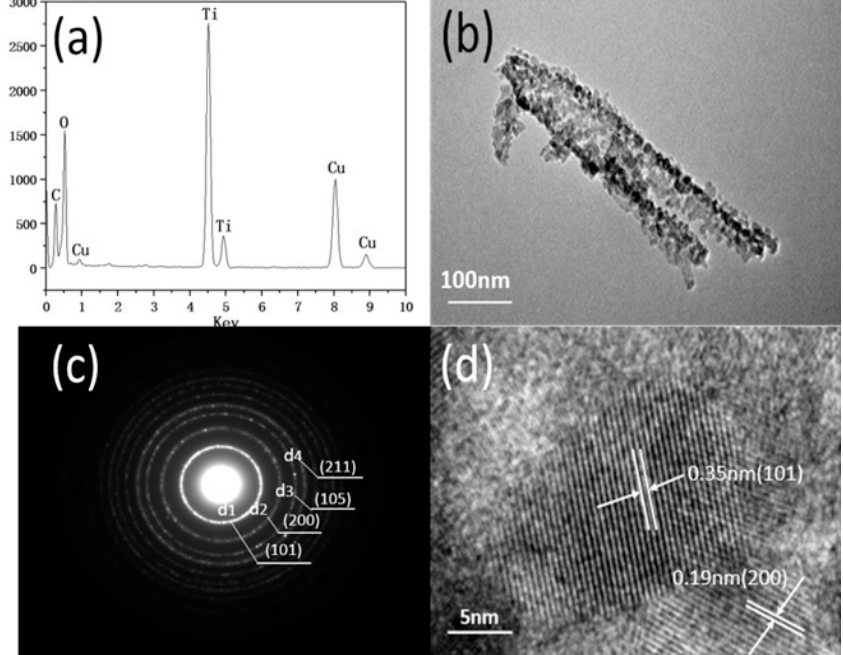
Figure 7. Characterization of TiO 2 nanotubes. ( a ) EDX spectra of TiO 2 samples. ( b ) TEM image of TiO 2 samples. ( c ) Electron di ff raction pattern of TiO 2 samples. ( d ) HRTEM image of TiO 2